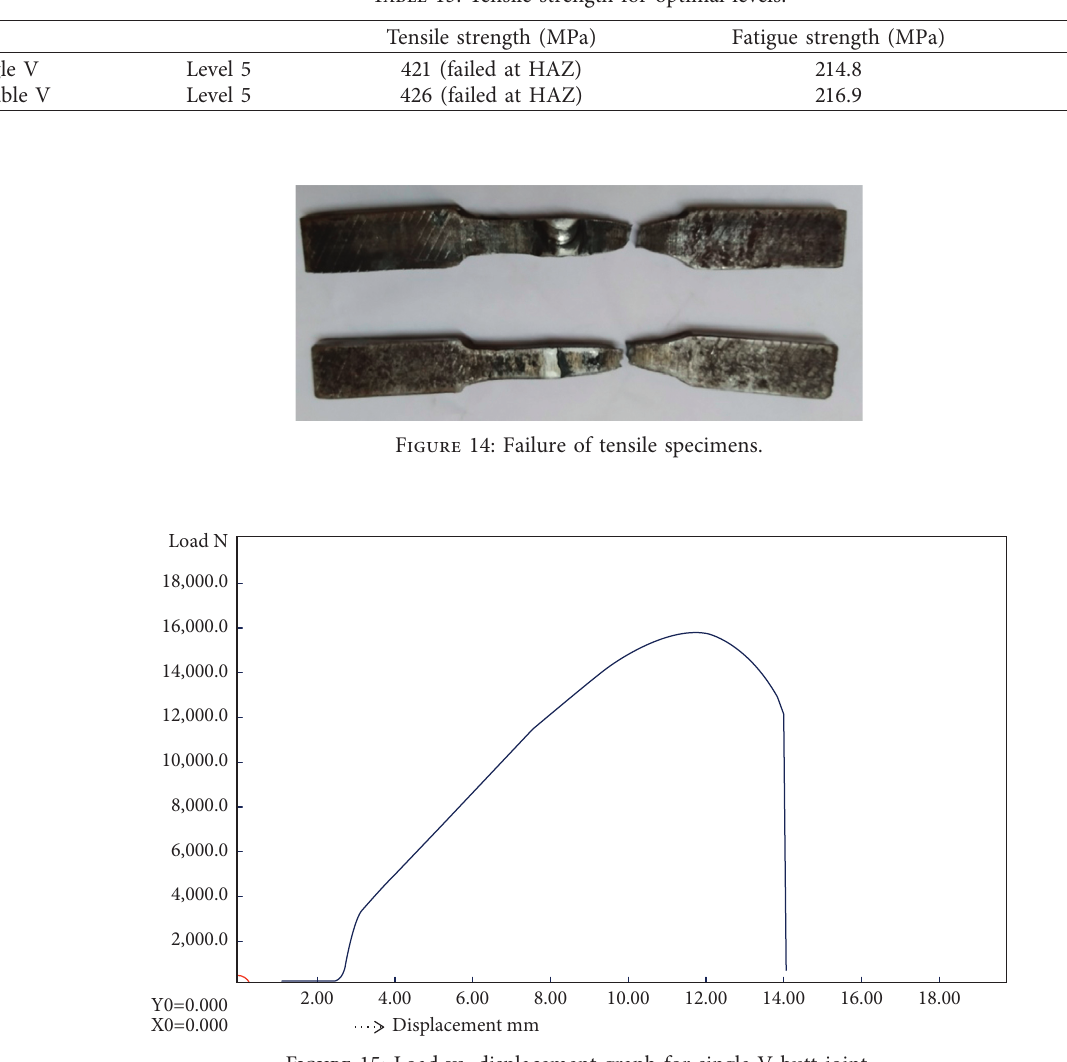
Figure 15: Load vs. displacement graph for single V butt joint.